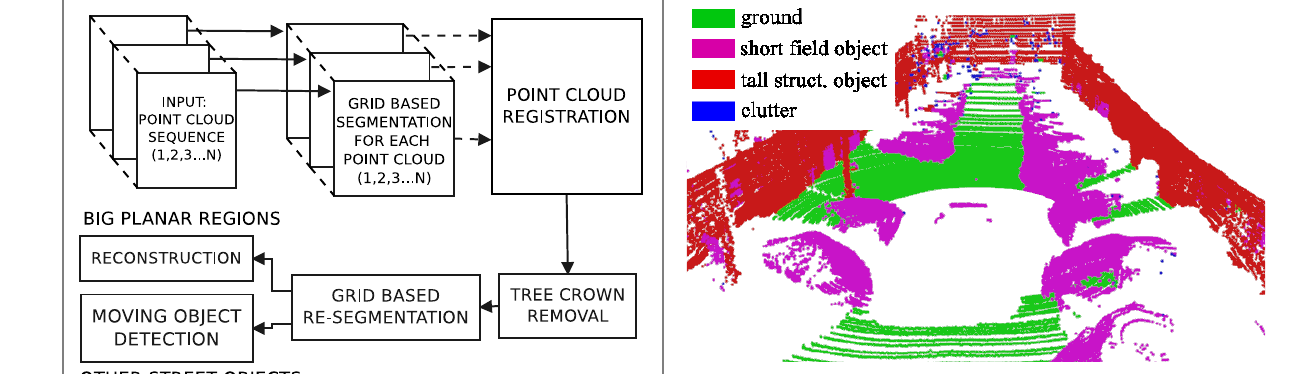
Figure 2: Segmented frame of the Velodyne point cloud